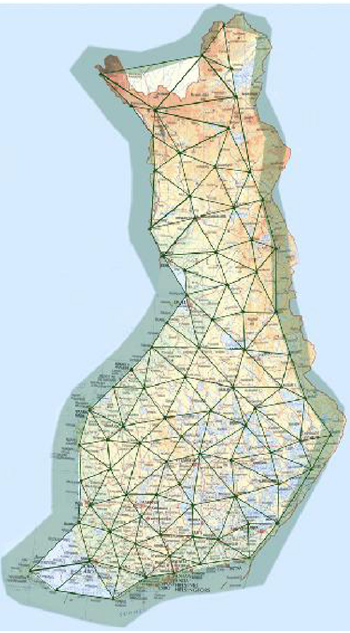
Fig. 2. Geotrim GPS receiver network over